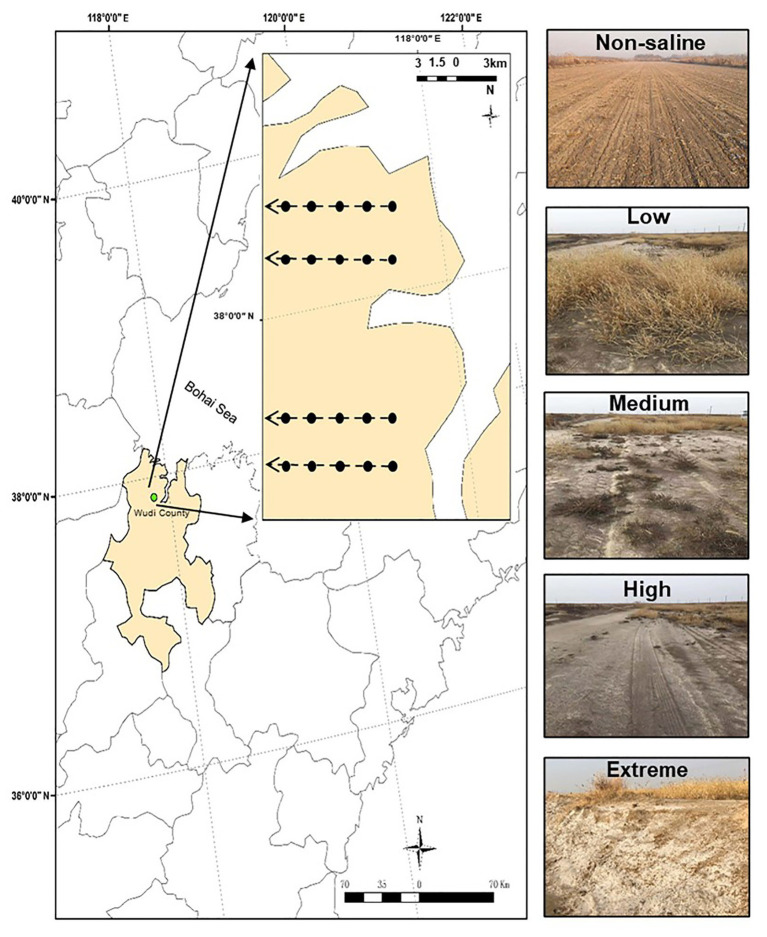
The study region and five salinity gradients with different EC values. The map was created with ArcGIS v 10.2 (http://www.esri.com/arcgis/about-arcgis). Non-saline: non-salted, Low: low-salinity soil, Medium: medium-salinity soil, High: high-salinity soil, and Extreme: extreme-salinity soil.